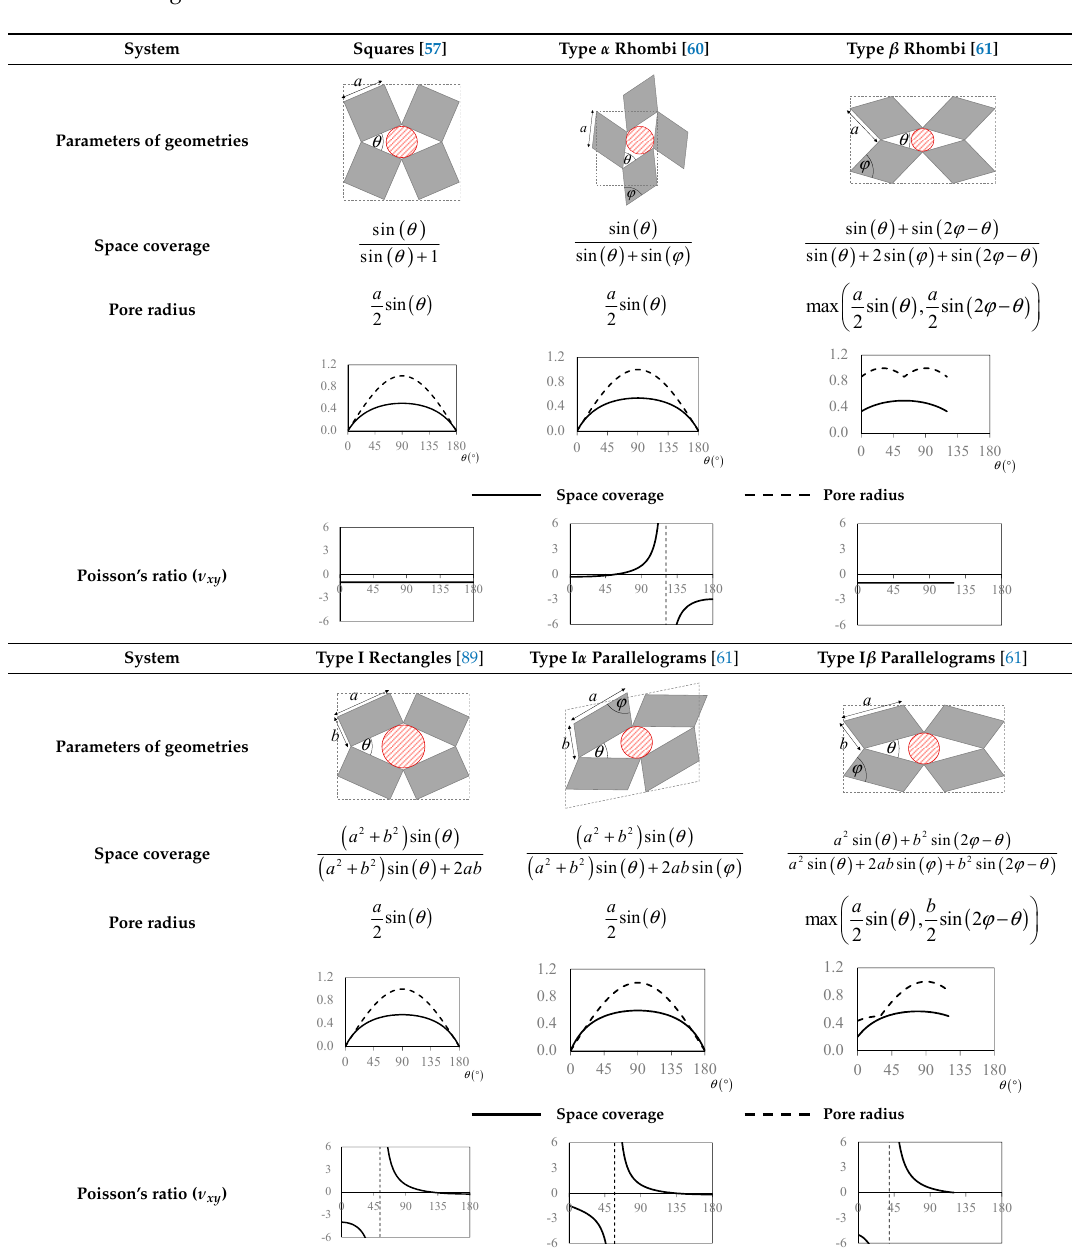
Table 2. Expressions relating space coverage, pore radius (radius of circle inscribed in the pore) and Poisson’s ratios to geometric parameters of the systems for cases where a > b . The vertical dashed line in the plots of the Poisson ratios represents asymptotic behavior that occurs when the system is locked in the loading direction. System Squares [57] Type α Rhombi [60] Type β Rhombi [61]